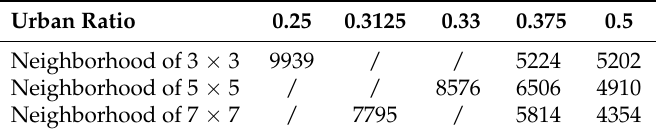
Table 3. Urban ratio tests.